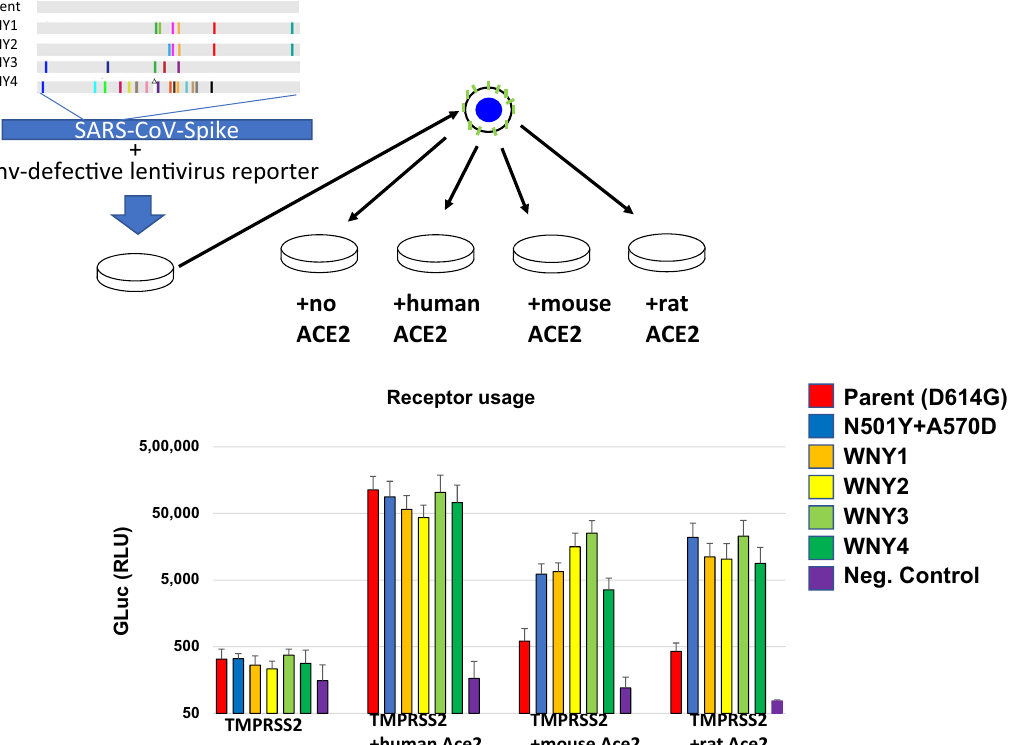
Fig. 2 ACE2 usage by WNY lineages. A Schematic of lineages and pseudovirion production. WNY1 = E484A/F486P/S494P/Q498Y/H519N/F572N, WNY2 = Q493K/S494P/Q498Y/H519N/T572N, WNY3 = K417T/K444T/E484A/F590Y/Q498H, WNY4 = K417T/N439K/K444N/Y449R/L452R/ N460K/S477N/ Δ 484/F486V/S494T/G496V/Q498Y/N501T/G504D/505H/H519Q. The indicated mutations were introduced into a codon-optimized SARS-COV-2 expression construct. These constructs were used to produce lentiviral pseudovirions containing a Gaussia luciferase reporter. Pseudoviruses containing SARS-COV-2 Spike with N501Y/A570D were used as a control as this is known to be capable of infecting rodent cells. Pseudoviruses were used to transduce 293FT + TMRPSS2 stably transduced with human, mouse, or rat ACE2. The average and standard deviation from three independent experiments is shown. A two-way ANOVA revealed signi fi cant differences in receptor utilization ( F = 17.81, DF = 3, 74; P < 0.0001). Source data are provided as a Source Data fi